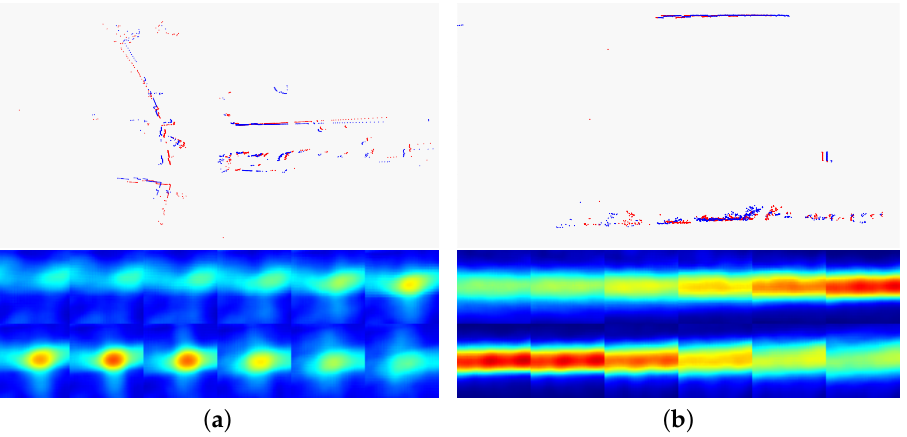
Figure 4. Comparative examples of different scenes. The cost function is visualized with each tile representing a slice of the cost volume for a fixed orientation. Red color represents high cost volume and blue color represents low cost volume. ( a ) An example with the value of k near 1.0. ( b ) An example with a small value of k